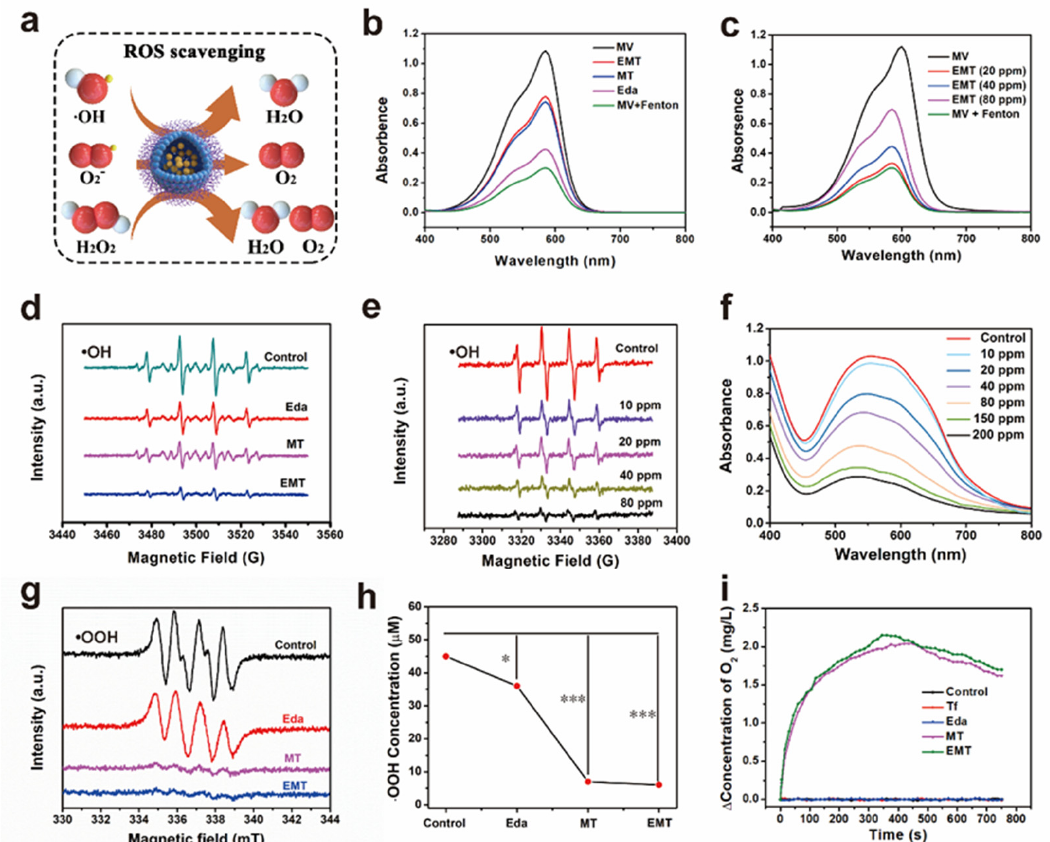
Figure 2. ROS-scavenging properties of the EMT nanozyme. ( a ) Schematic illustration of the EMT nanozyme to mimic enzyme-like antioxidation. ( b ) UV-vis absorption spectra of MV + Fenton to evaluate the oxidation resistance of Eda, MT, and EMT. ( c ) UV-vis absorption spectra of MV to evaluate the oxidation resistance of EMT at different concentrations (20 ppm, 40 ppm, and 80 ppm). ( d ) ESR spectra of Eda, MT, and EMT groups for evaluating the ability to remove •OH. ( e ) ESR spectra of the EMT nanozyme with different concentrations (10 ppm, 20 ppm, 40 ppm, and 80 ppm) for